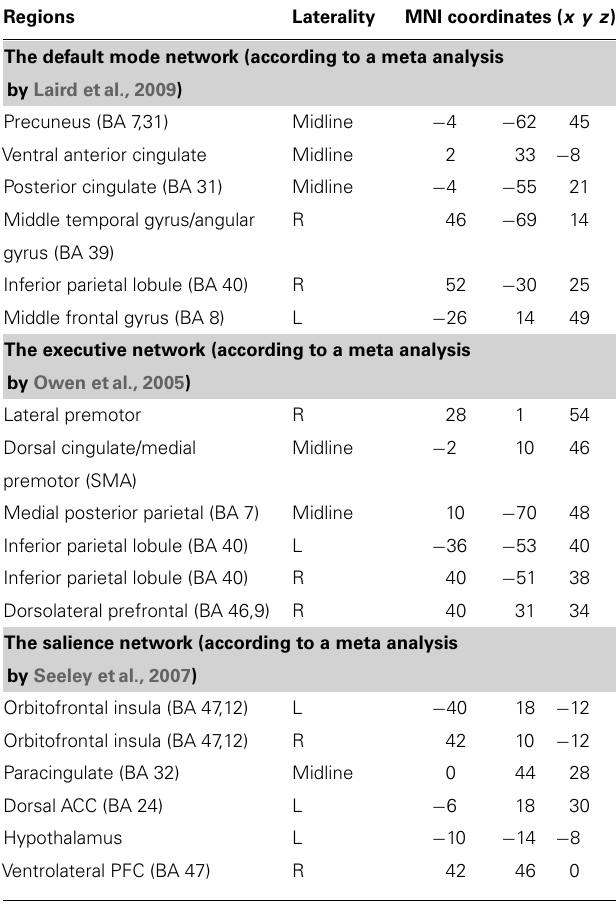
Table 1 | ROIs from the default-mode, executive and salience networks included in the analysis.